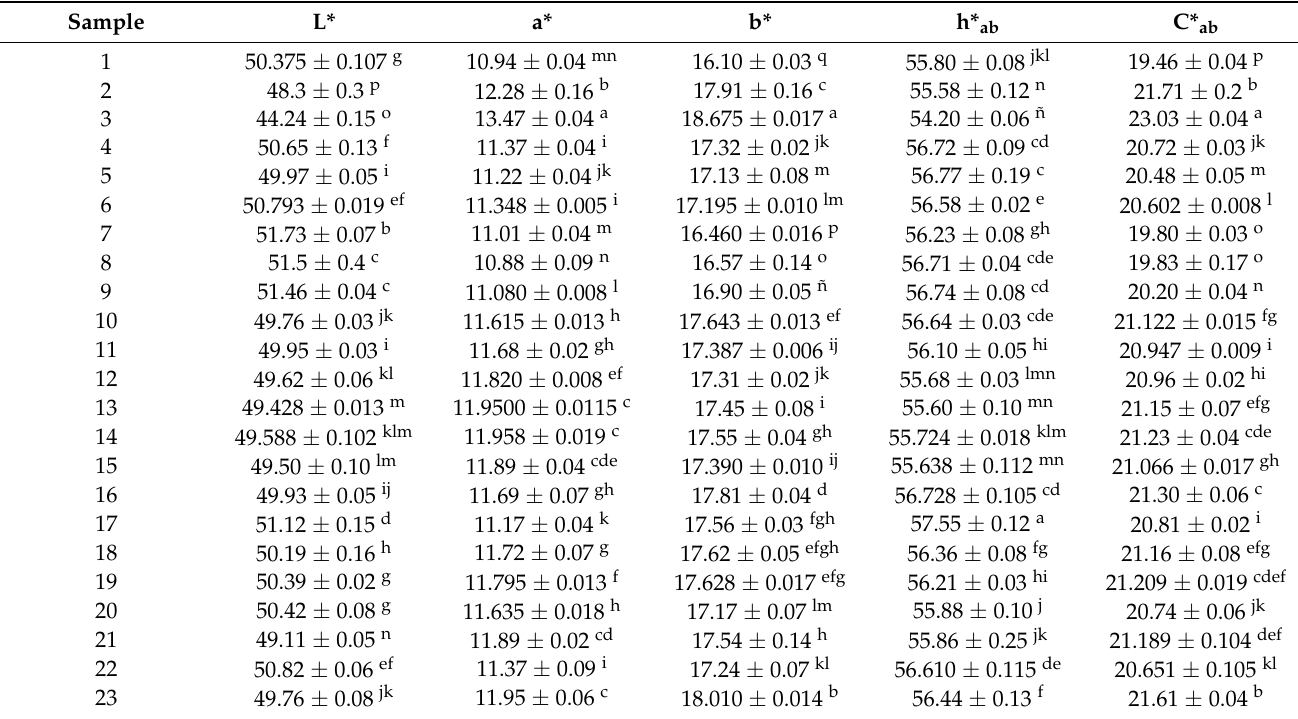
Table 3. Mean ± and standard deviation of the color coordinates (L*, a*, b*, h* ab and C*ab) of each of the samples obtained. Superscript letters within columns indicate homogeneous groups according to ANOVA ( p <